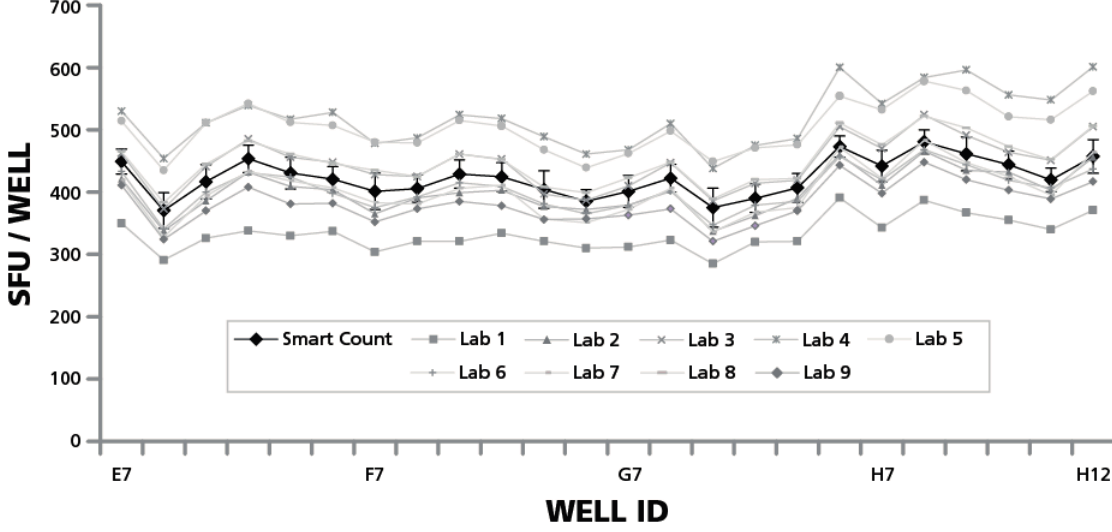
Figure 7. Average of subjective counts approximates that of SmartCount™. Spot counts obtained by the nine participating scientists in Basic Count™ mode are represented by grey lines with different symbols, as specified. The average counts obtained in SmartCount™ mode by the nine scientists and the respective SD for each well ID are shown with the black line. Data are shown for the 1.5 × 10 5 cells/well quadrant of the RP, with the well IDs specified. The data are representative for the other three quadrants of the plate as